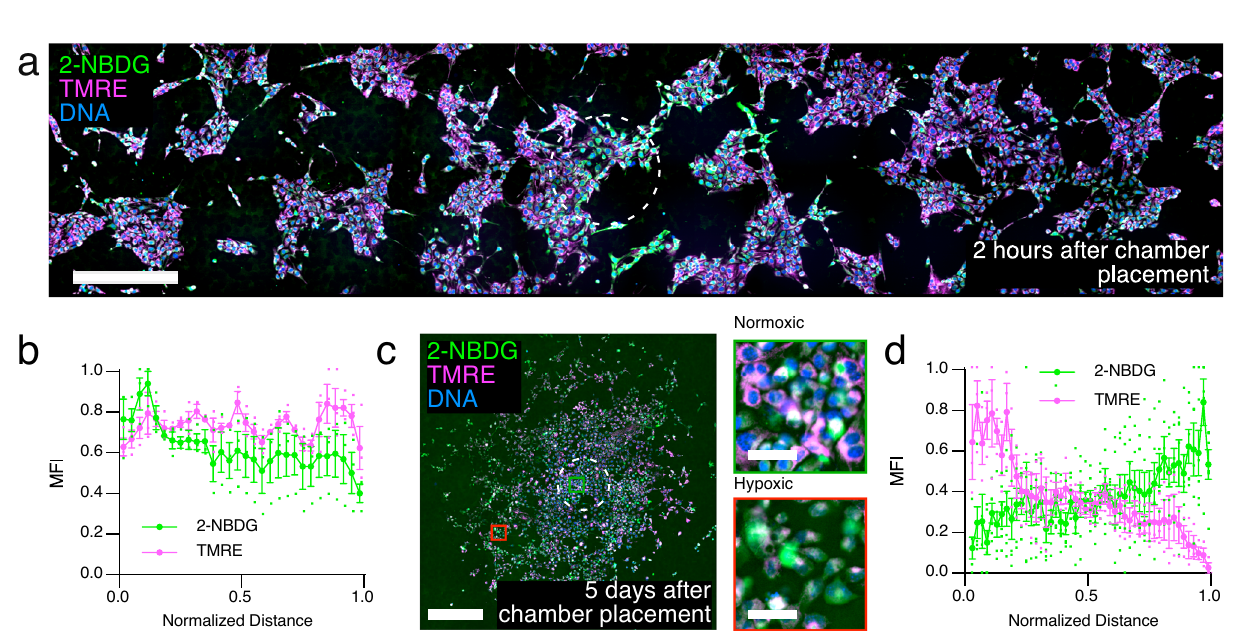
Fig. 2 Nutrient uptake and metabolic activity vary with [O 2 ] concentration gradient between 2 h and 5 days in the 4T1-REEC model of the TME. a Wide fi eld of image of 2-NBDG uptake and TMRE fl uorescence in a 4T1-REEC 2 h after chamber placement. Scale bar = 500 µ m. b Quanti fi cation of 2- NBDG and TMRE fl uorescence in 4T1-REECs 2 h after chamber placement ( N = 3). Correlation coef fi cient of 2-NBDG, TMRE = 0.1748. c Wide fi eld image of 2-NBDG and TMRE fl uorescence in a 4T1-REEC 5 days after chamber placement. Magni fi ed areas of normoxic (green square) and hypoxic (red square) cells are displayed to the right of the image. Scale bar = 500 µ m, inset scale bars = 50 µ m. d Quanti fi cation of 2-NBDG ( N = 6 disks) and TMRE ( N = 3 disks) fl uorescence in 4T1-REECs 5 days after chamber placement. Correlation coef fi cient of 2-NBDG, TMRE = − 0.5089. Dashed lines indicate the opening. MFI mean fl uorescence intensity. Data plotted as mean ±